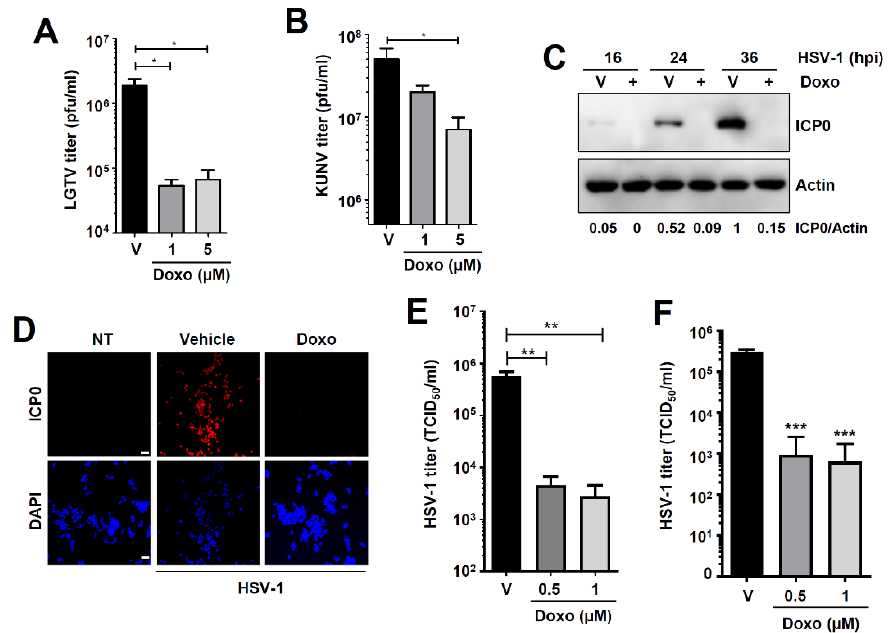
Figure 7. Doxorubicin inhibits flavivirus and herpes simplex virus 1 (HSV-1) replication. ( A , B ) Vero cells were infected with Langat virus (LGTV) ( A ) or Kunjin virus (KUNV) ( B ) in the absence or the presence of doxorubicin (Doxo, at the indicated doses). Virion production was analyzed by plaque assay. ( C ) MDA-MB-453 cells were infected with HSV-1 in the absence or the presence of doxorubicin. The expression of viral protein infected cell protein 0 (ICP0) was analyzed by immunoblot at the indicated times post-infection. ( D ) MDA-MB-453 cells were infected with HSV-1 in the absence or the presence of doxorubicin. The expression of viral ICP0 protein was analyzed by confocal microscopy 24 h post-infection. Scale bar 50 µ m. ( E , F ) MDA-MB-453 cells were infected with HSV-1 (KOS strain, E or F strain, F) in the absence or the presence of doxorubicin for 24 h when the infectious virion release was analyzed by TCID50 assay. Vehicle (V), DMSO treatment, * indicates p < 0.05, ** p < 0.01, *** p < 0.001.